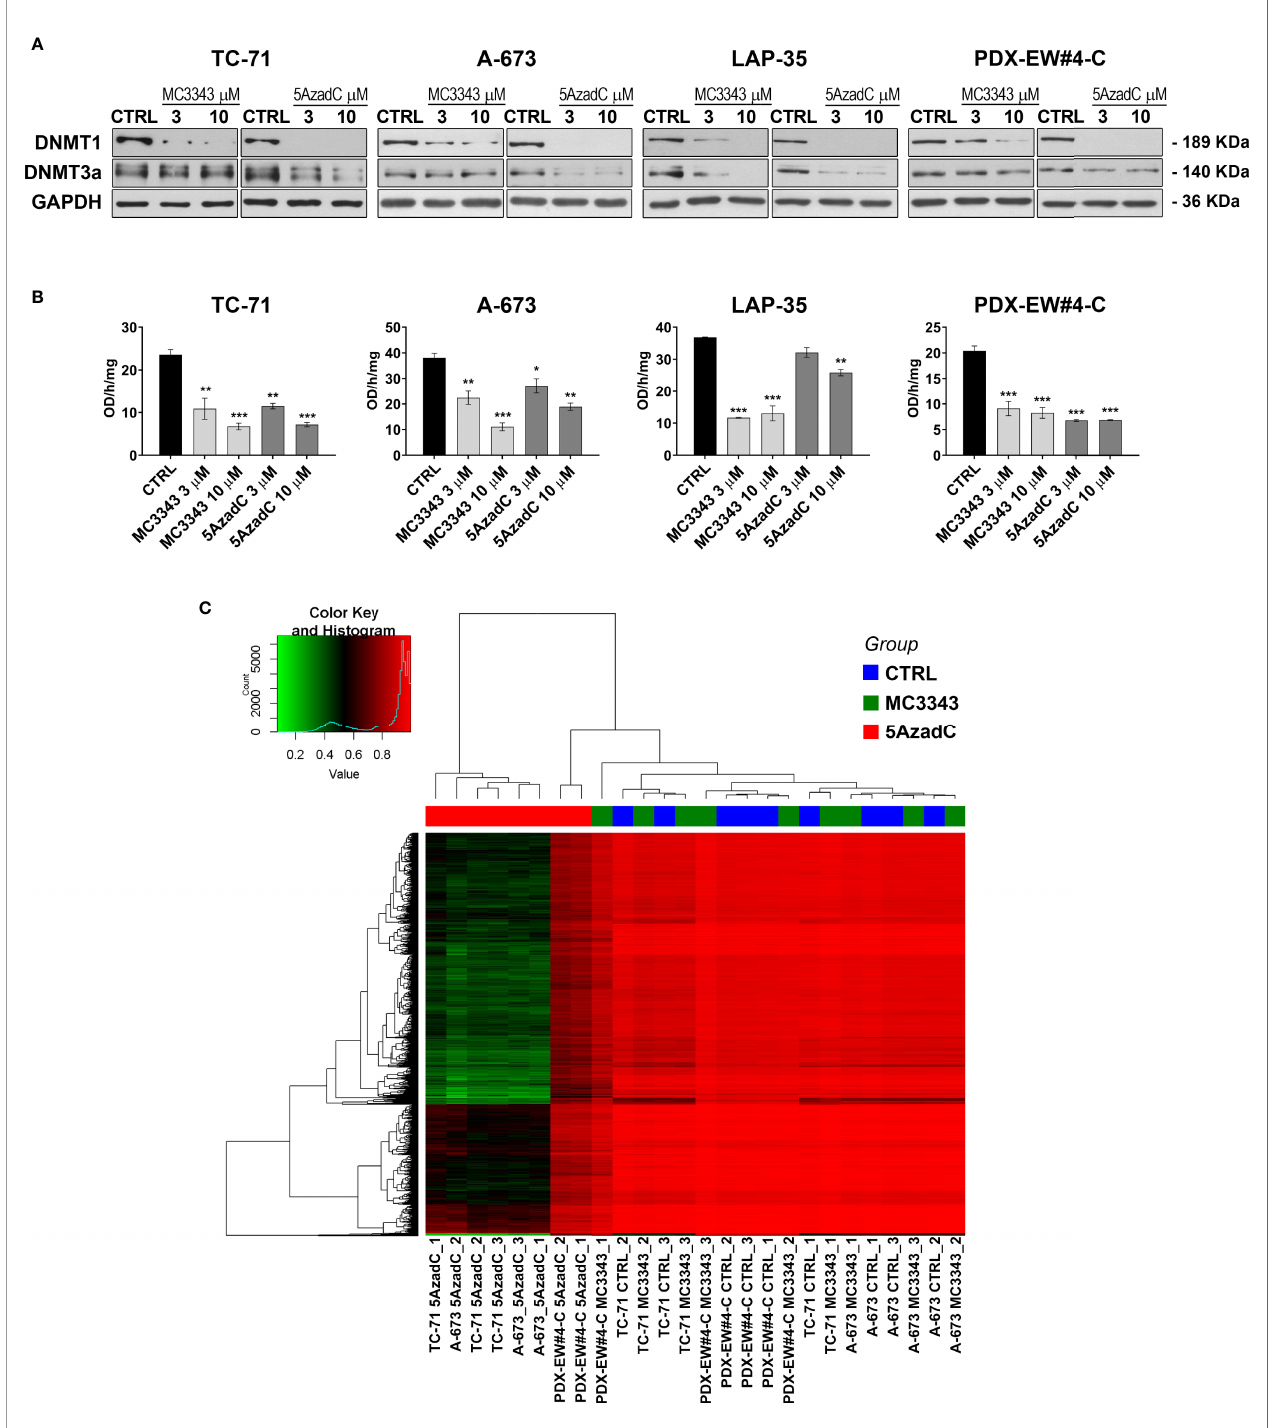
FIGURE 1 | MC3343 ef fi ciently reduces DNMT protein level and enzymatic activity in EWS cells but DNA methylation status is left unaltered. (A) Western blot analysis of DNMT1 and DNMT3a, in untreated (CTRL), MC3343-treated (3 – 10 m M), and 5azadC-treated (3 – 10 m M) TC-71, A-673, LAP-35 and PDX-EW#4-C cells. Equal protein loading was monitored by anti-GAPDH blotting. One representative immunoblot of three independent experiments is shown. (B) DNMT activity measured in EWS cells after MC3343 and 5azadC treatments expressed as OD (optical density)/hours/mg (*p < 0.05; **p < 0.01, ***p < 0.001, one-way ANOVA test). The mean ± SE of three independent experiments are reported. (C) Heatmap illustrating the difference of methylation between EWS cells treated with MC3343 and